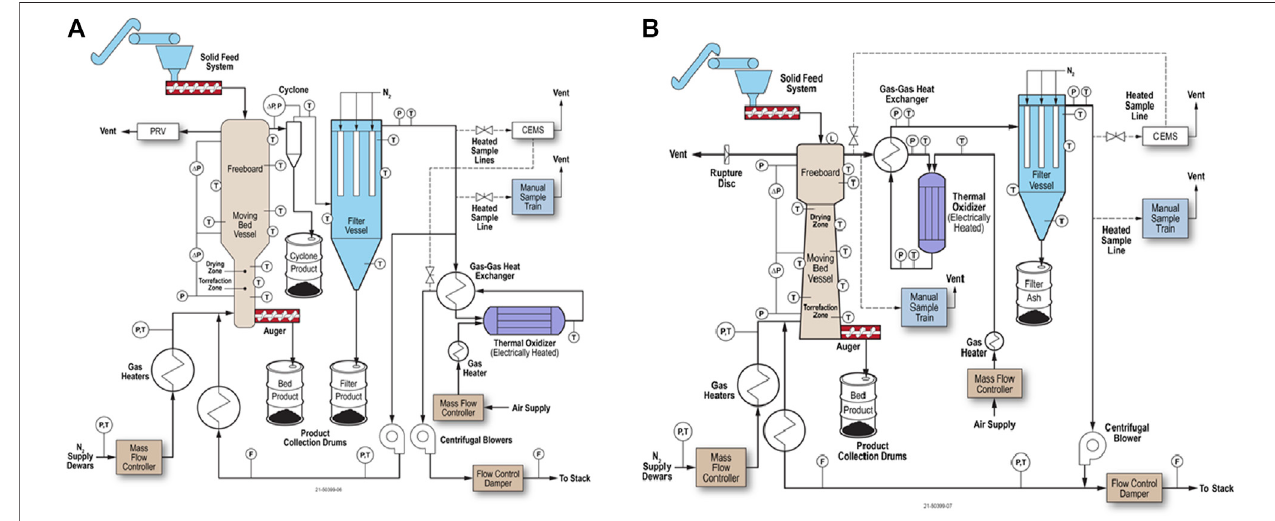
FIGURE 10 | Torrefaction system diagram showing a vertical moving bed torre fi er: (A) with counter- fl owing gas and biomass where only the torre fi er gas that is discharged is oxidized; and (B) with a negative-sloped torre fi er and process gas oxidation upstream of fi ltration.